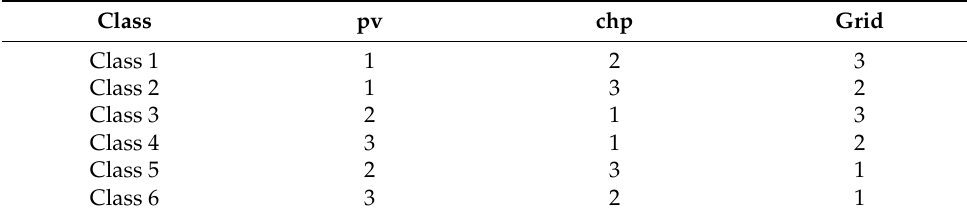
Figure 6. Example capacity shares derived from energy flows (electricity). Table 2. Priority lists as defined classes (electricity).